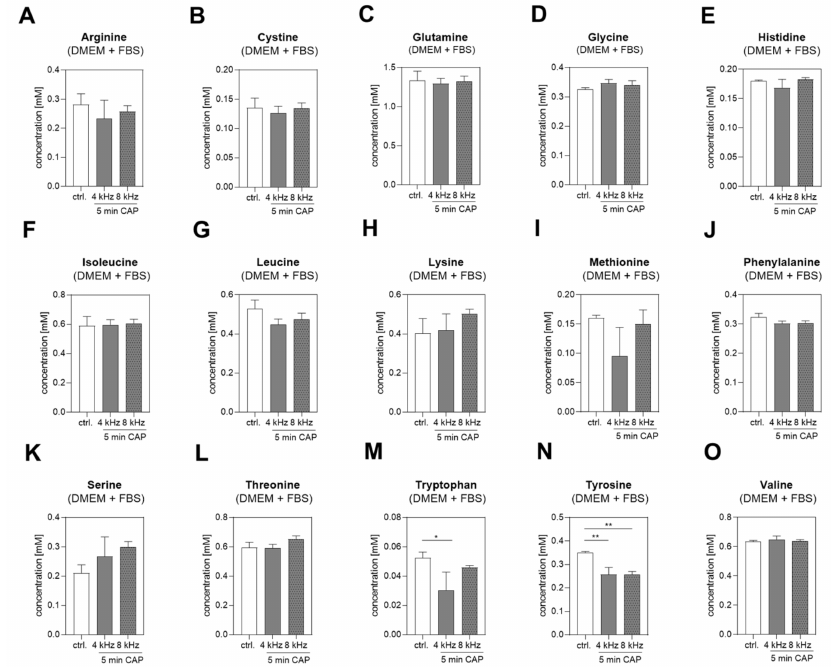
Figure 2. Amino acid concentrations in DMEM + FBS PTS. The concentrations of 15 amino acids ( A – O ) were measured by NMR spectroscopy in untreated DMEM + FBS (control), and after 5 min of 4 kHz and 8 kHz CAP treatment (n = 3). Statistical analysis: Bonferroni’s multiple comparisons test.